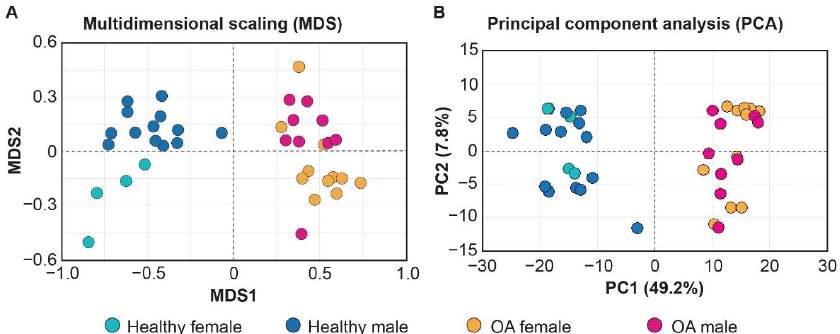
Figure 1. Multidimensional scaling (MDS) ( A ) and principal component analysis (PCA) ( B ) distinguish transcriptome of healthy and osteoarthritis (OA) cartilage samples included in the current study.